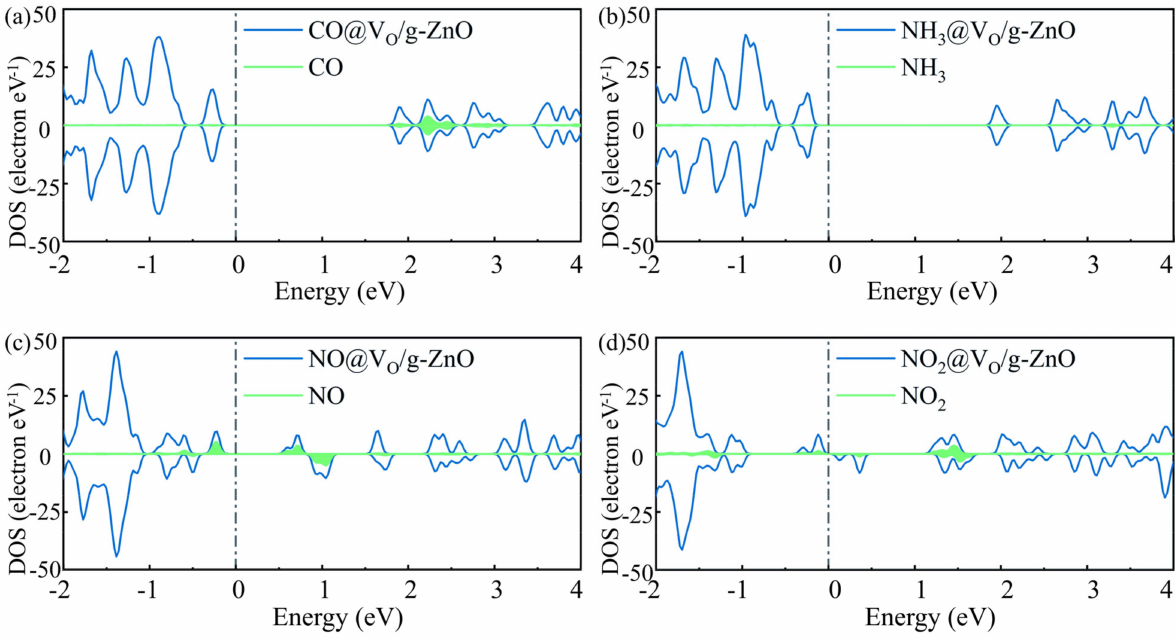
Figure 10. DOS of ( a ) CO, ( b ) NH 3 , ( c ) NO, or ( d ) NO 2 adsorbed on V O /g − ZnO systems. For the gas adsorption V O /g − ZnO system, the CO and NH 3 gas molecules have no contribution within the forbidden band of V O /g − ZnO, and the NH 3 gas molecules have almost no contribution to the total DOS. Therefore, no significant change in DOS compared to that of V O /g − ZnO. The DOS of the NO@ V O /g − ZnO system and the NO 2 @ V O /g − ZnO system are asymmetric in the upper and lower Brillouin zone, suggesting that the adsorption of NO and NO 2 gases induces magnetism. In the NO@ V O /g − ZnO system, the VBM and CBM are mainly contributed by NO gas molecules. However, in the NO 2 @ V O /g − ZnO system, the NO 2 contribution to the in-band DOS of V O /g − ZnO is